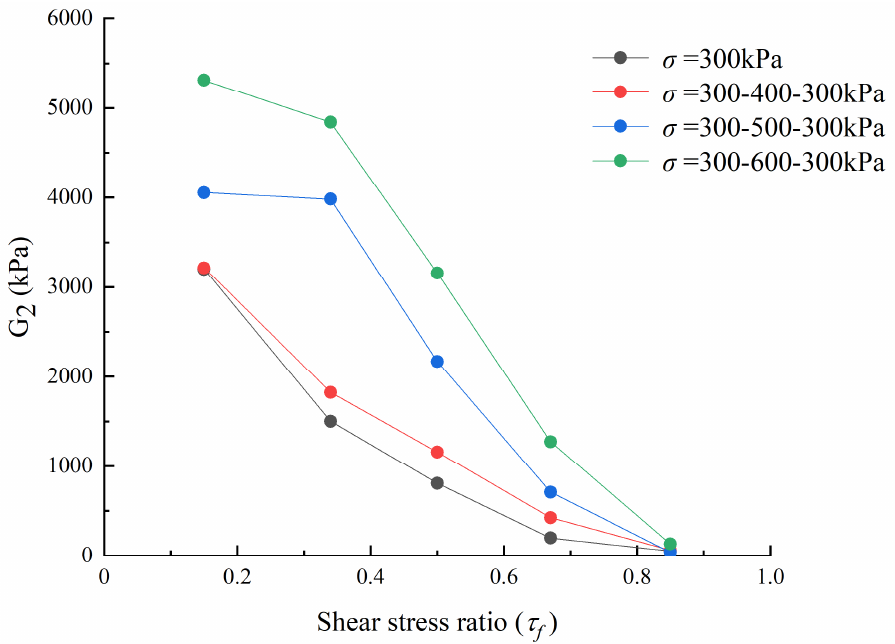
Figure 15. The curve of shear modulus G 2 versus shear stress under different loading amplitude R.